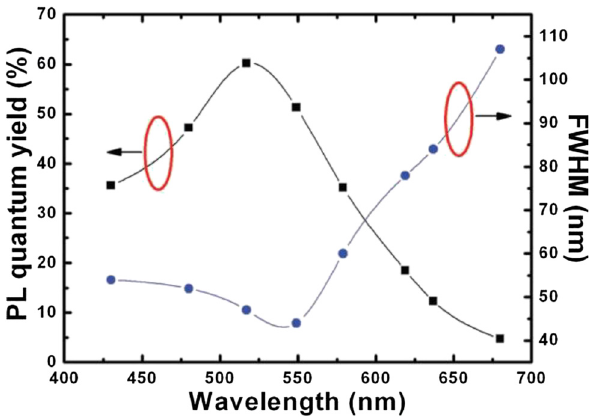
Figure 12: Evolution of fluorescence QY and FWHM of InP/ZnS NCs with different ratios of InP:ZnS (increasing the ratio of InP to ZnS from left to right)